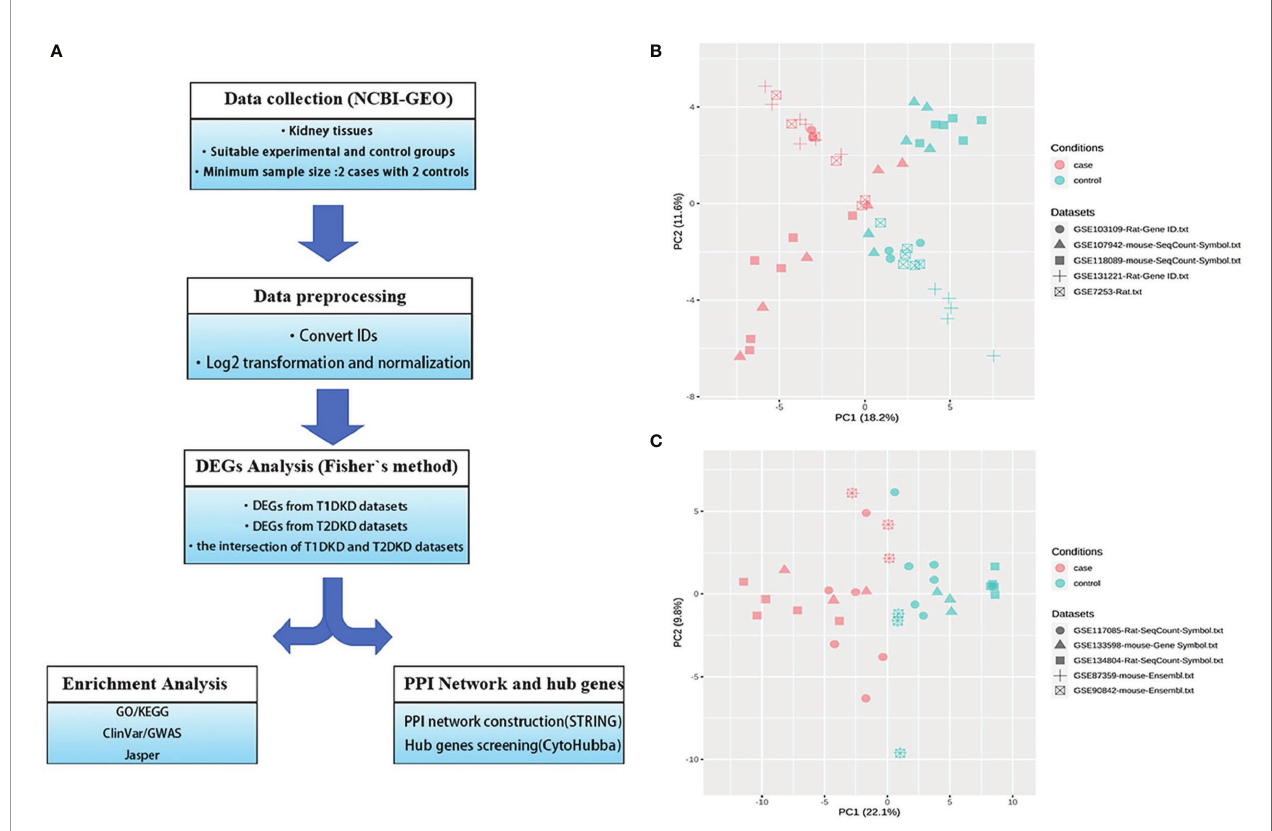
FIGURE 1 | Data collection and processing: (A) The Meta-analysis fl owchart. The main methods in each stage are described in the corresponding parentheses. (B, C) Principal component analysis (PCA) of the combined datasets after batch effect correction. All samples are represented by different symbols with shapes according to their studies and colors based on their experimental conditions. (B) T1DKD datasets. (C) T2DKD